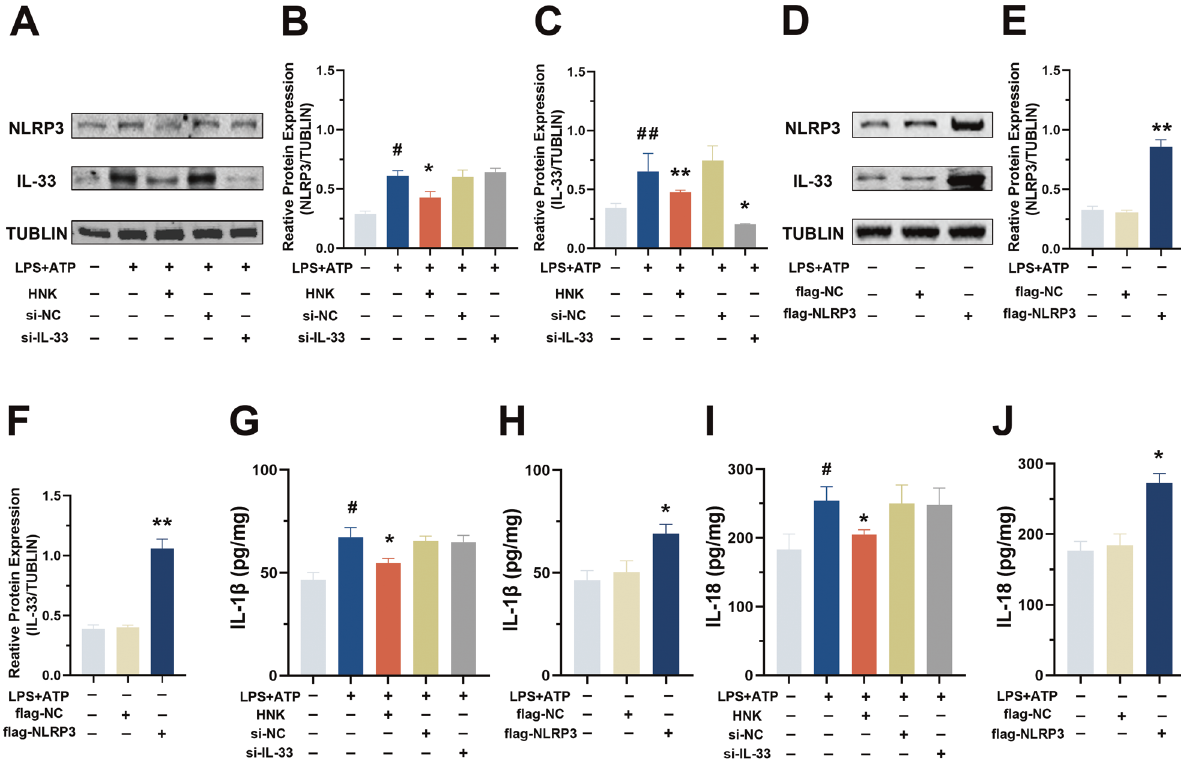
Fig. 6 NLRP3 regulates IL-33 expression in renal resident macrophages. A – F Protein levels and gray-scale analysis of NLRP3 and IL-33 (*/# p < 0.05,**/## p < 0.01; #versus MPJ group; * versus lpr group). G – J IL-1 β and IL-18 levels in the cell-culture supernatant (# p < 0.05, versus the blank control; * p < 0.05, versus the LPS + ATP